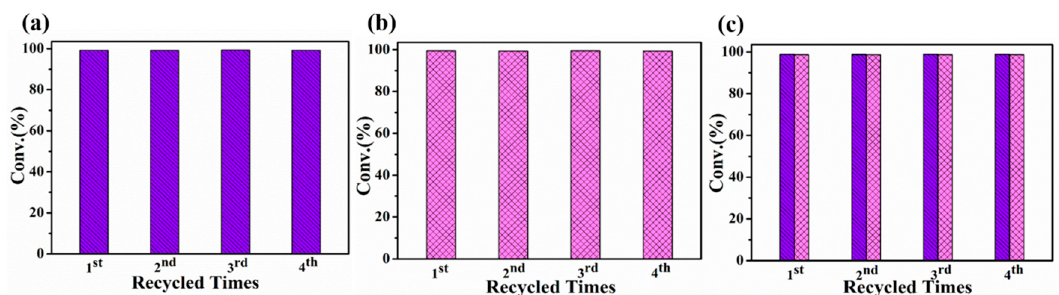
Figure 5. Cycling test on CuS for the photocatalytic degradation of ( a ) MB, ( b ) RhB, and ( c ) MB/RhB under simulated solar light irradiation.